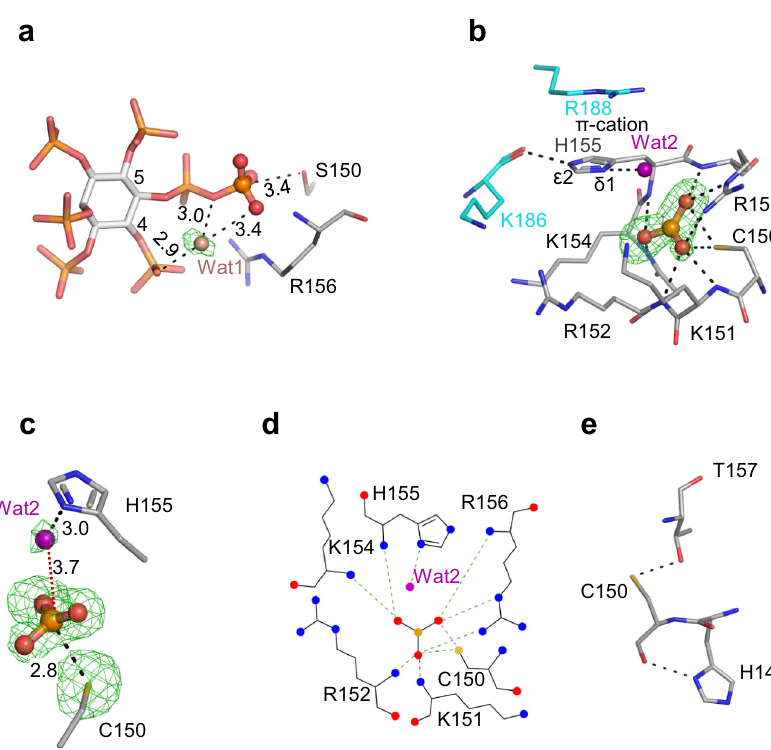
Fig. 6 The formation of a metaphosphate-like reaction intermediate in At PFA-DSP1 49 – 215 . a the relative positions of a catalytic water (Wat1; pink sphere) and 5-InsP 7 (stick format) in a crystal complex with AtPFA-DSP1 49 – 150,C150S,151 – 215 (PDB accession code 7MOD); polar interactions are highlighted with broken black lines, with bond distances marked in Å. The omit Fo-Fc electron density map is contoured at 5 σ and shown in green mesh. b a reaction intermediate that we designate to be a metaphosphate anion (ball and stick format; orange for phosphorus, red for oxygens). The crystal complex depicted in this panel was obtained by soaking 0.1 mM 5-InsP 7 into At PFA-DSP1 49 – 215 at pH 8.0 for 2 h (7MOM; Supplementary Table 1). Broken black lines designate polar interactions with residues (stick format; blue for nitrogen, yellow for sulfur). The omit Fo-Fc electron density map is contoured at 4 σ and shown in green mesh. A putative reactive water molecule (Wat2) is shown as a purple sphere. Distances are described in Å. His155 is shown in N ε 2 - protonated τ tautomer state. c relative positions of Wat2 and the putative metaphosphate to illustrate distances between elements (Å); those within polar interaction distance are depicted as broken gray lines. The omit Fo-Fc electron density map is contoured at 4 σ and shown in green mesh. Panel ( d ) is a rendering of the corresponding ligand – protein interactions created by Ligplot + . Panel ( e ) shows polar interactions (<3.2 Å; broken black lines) that Cys150 has with Thr157 and